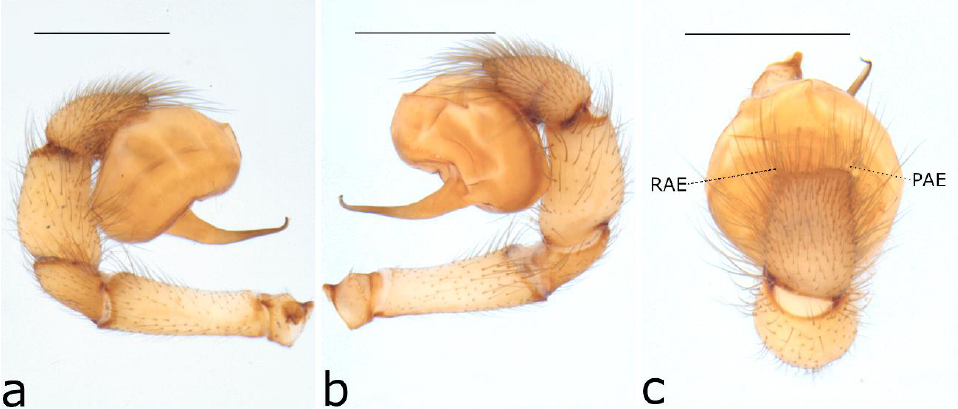
Figure 45. Ariadna pollex sp. nov. ♂ holotype (SAMA NN30485) from Purni Bore (SA): ( a ) left pedi- palp, prolateral view; ( b ) same, retrolateral view; ( c ) same, cymbium. Scale bar = 1 mm. Ariadna propria sp.